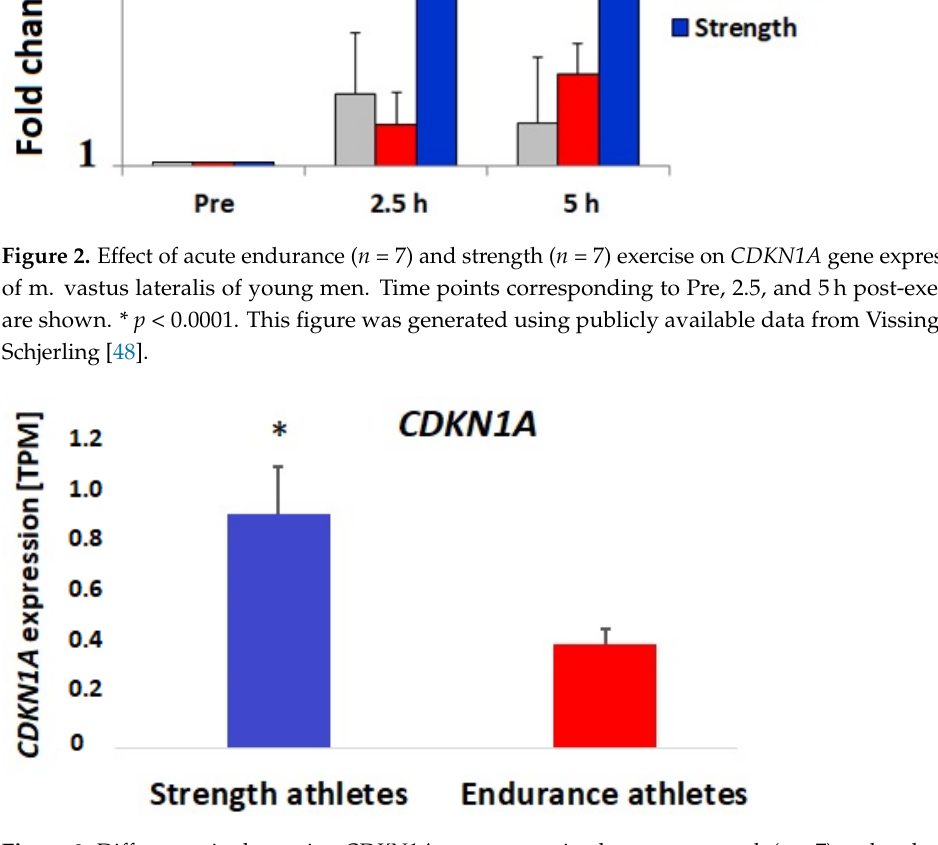
Figure 3. Differences in the resting CDKN1A gene expression between strength ( n = 7) and endur- ance ( n = 11) athletes. * p =